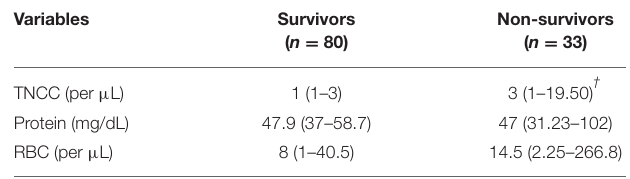
TABLE 4 | Comparison of fluid analysis parameters in survivors and